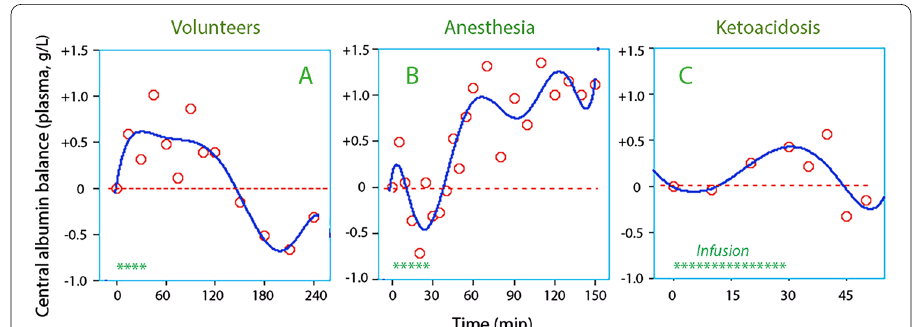
Fig. 2 Albumin recruitment during crystalloid fluid therapy. The y -axis shows plasma albumin concentration that is due to interstitial washdown. Technically, each data point is the product of the Hb–albumin difference in plasma dilution and the plasma albumin concentration in A 20 volunteers receiving 1.7 L of Ringer’s acetate, B 30 patients given 1.7 L of Ringer’s acetate thyroid surgery, and C 31 infusions of 1 L of 0.9% saline in patients treated for diabetic ketoacidosis. Each infusion was given over 30